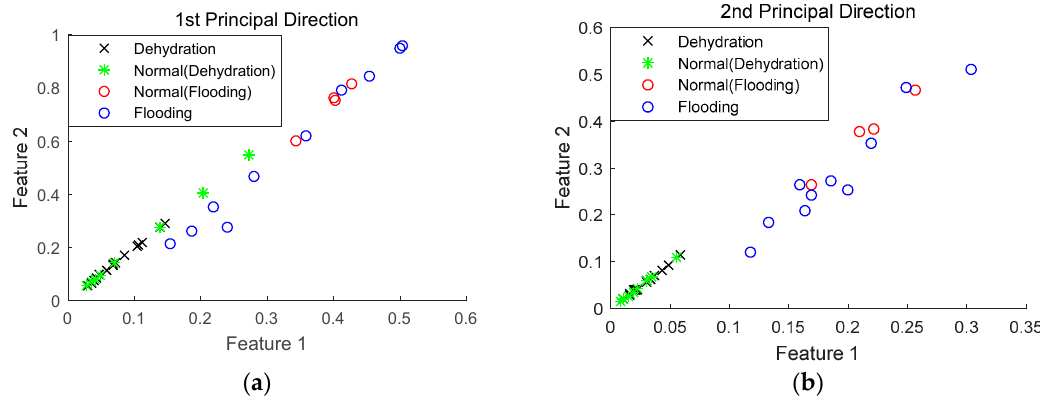
Figure 5. Fault diagnosis performance using all available sensors. ( a ) 1st principal direction; ( b ) 2nd principal direction.